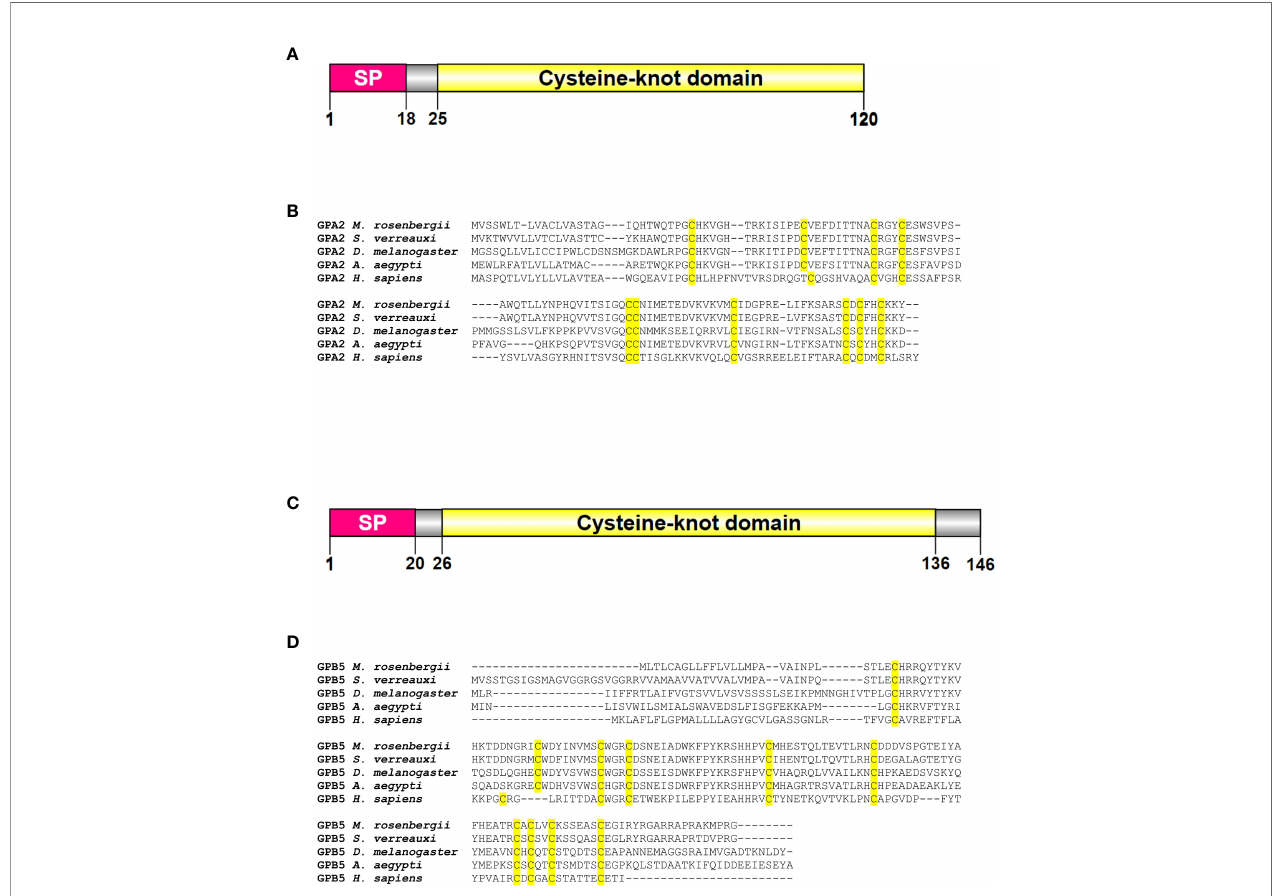
FIGURE 1 | M. rosenbergii glycoprotein hormone subunits and deduced protein sequences. Linear models of the (A) GPA2 and (C) GPB5 proteins of M. rosenbergii showing the conserved predicted domains of the proteins containing a signal peptide and a cysteine-knot domain. The location of the amino acids in the protein is scaled. Multiple sequence alignment of (B) GPA2 and (D) GPB5 from M. rosenbergii , S. verreauxi , A. aegypti , D. melanogaster and H. sapiens demonstrates the conservation of key cysteine residues (highlighted in